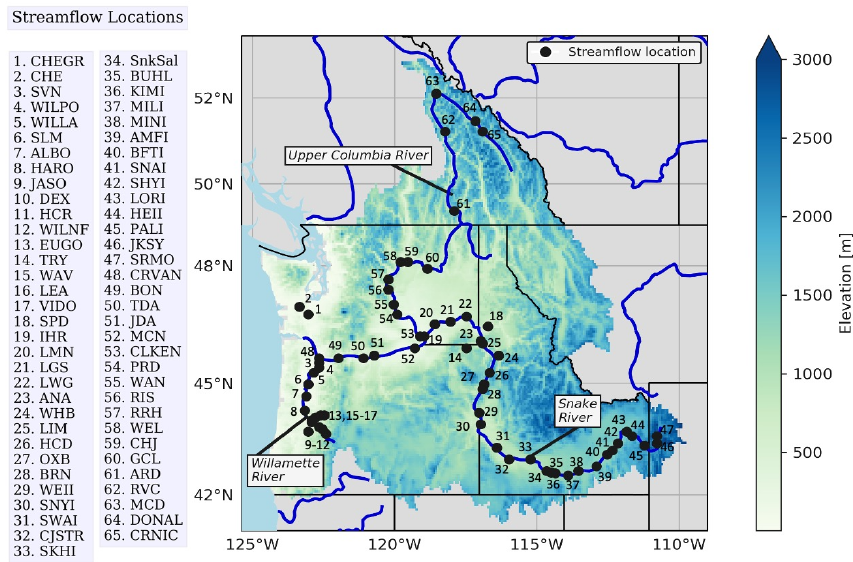
Figure 1. Domain of hydrologic simulations used in this paper, with colors indicating elevation of each grid cell, major rivers highlighted in blue, and numbers indicating locations of streamflow points highlighted in Figs. 6–11 and Table 1. See Chegwidden et al. (2017, 2019) for all streamflow locations plotted in Fig.